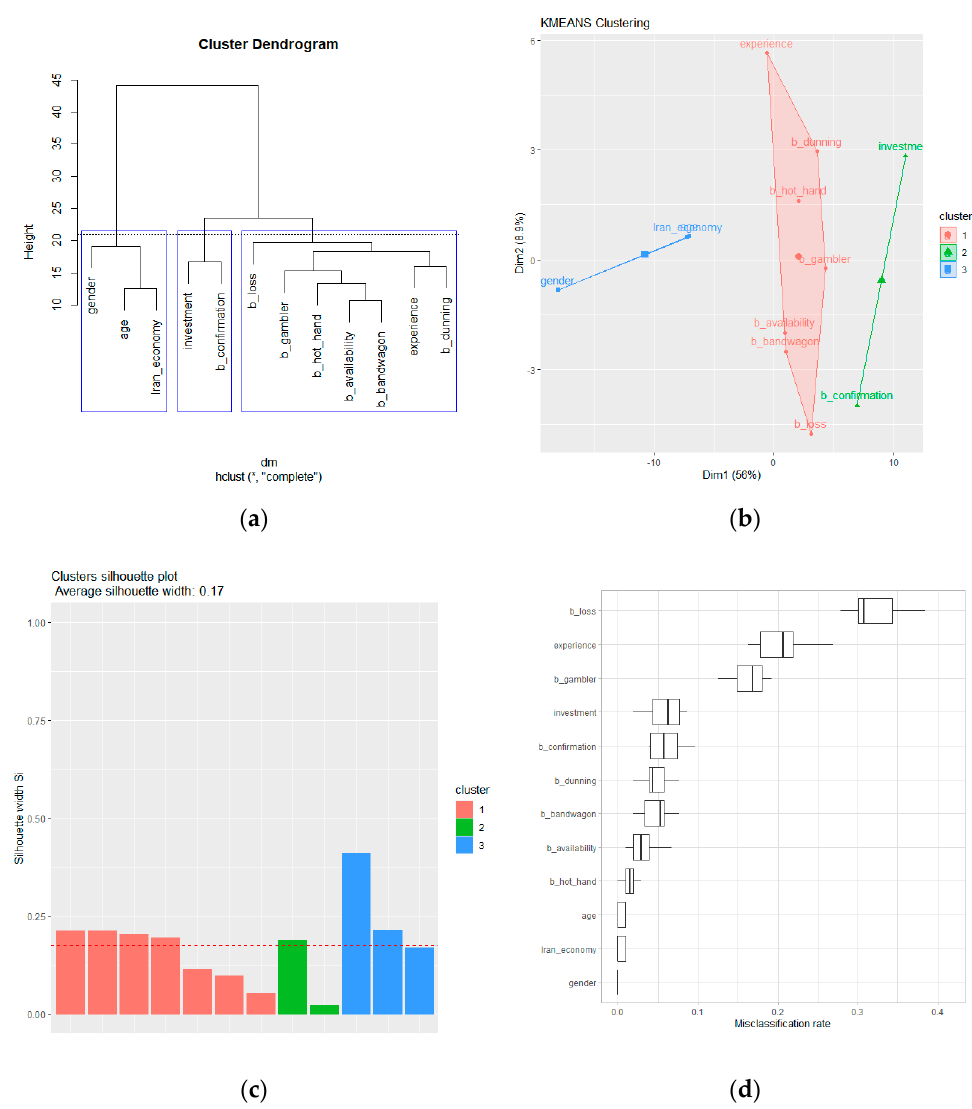
Figure 5. Clustering of variables: ( a ) dendrogram in hierarchical clustering; ( b ) PCA-reduced dimensions of k-means clustering; ( c ) silhouette statistic; ( d ) feature importance. Note: K-means output ( b ) was PCA-reduced for 2D visualisation purposes; labels of x and y axes show the variance around the first and second principal components. Feature importance ( d ) is measured through misclassification rate; the higher the misclassification rate, the more important given feature.